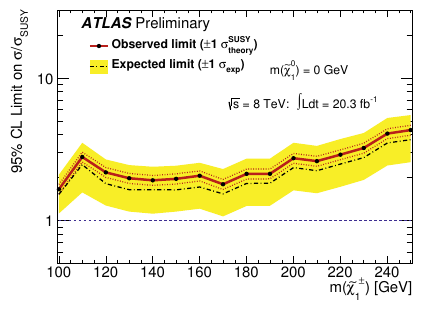
Figure 13: Observed and expected 95% CLs upper limits of the cross-section as a func- tion of m ˜ χ + for massless ˜ χ 0 1 normalised to the 1 simplified-model cross-section. The excluded cross-section is above the model cross-section ± by a factor 1.9 - 2.8 in the ˜ χ 1 mass range 100 - 190 GeV and then degrades gradually to 4.7 ± when reaching ˜ χ 1 mass of 250 GeV. Best sen- , m sitivity is obtained for the ( m ˜ χ + ) = (100, 0) ˜ χ 0 1 1 GeV mass point where σ/σ SUSY = 1.8.